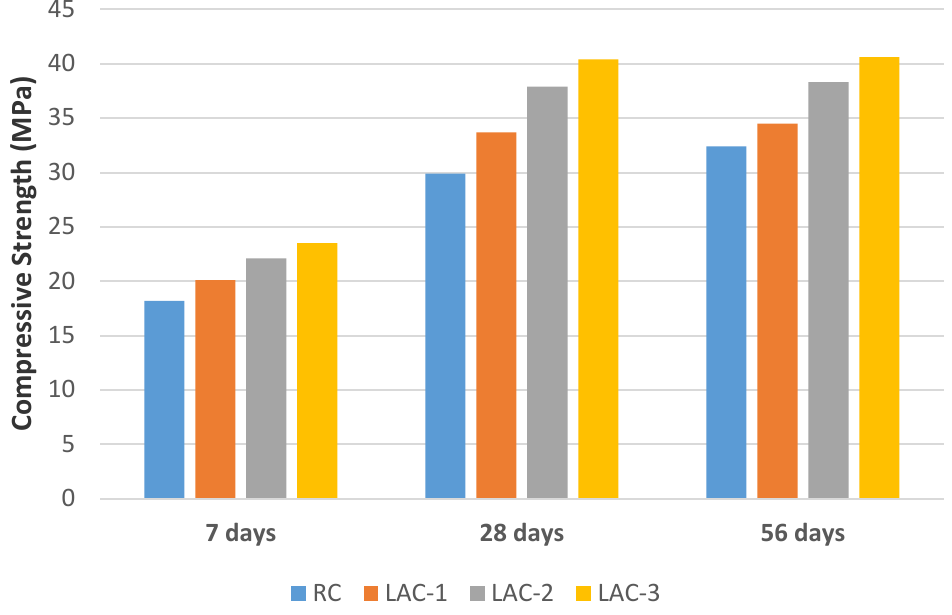
Figure 5. The compressive strength test results of the mixes.